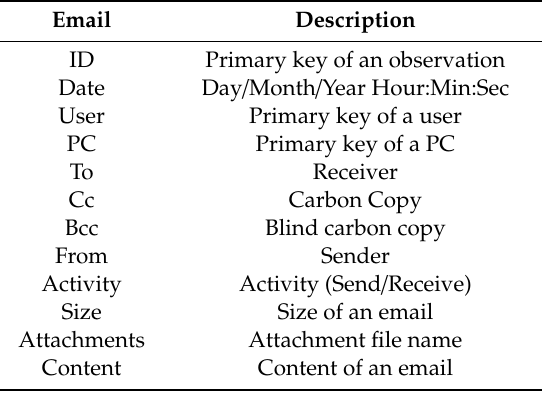
Table 6. Log records of email activities.